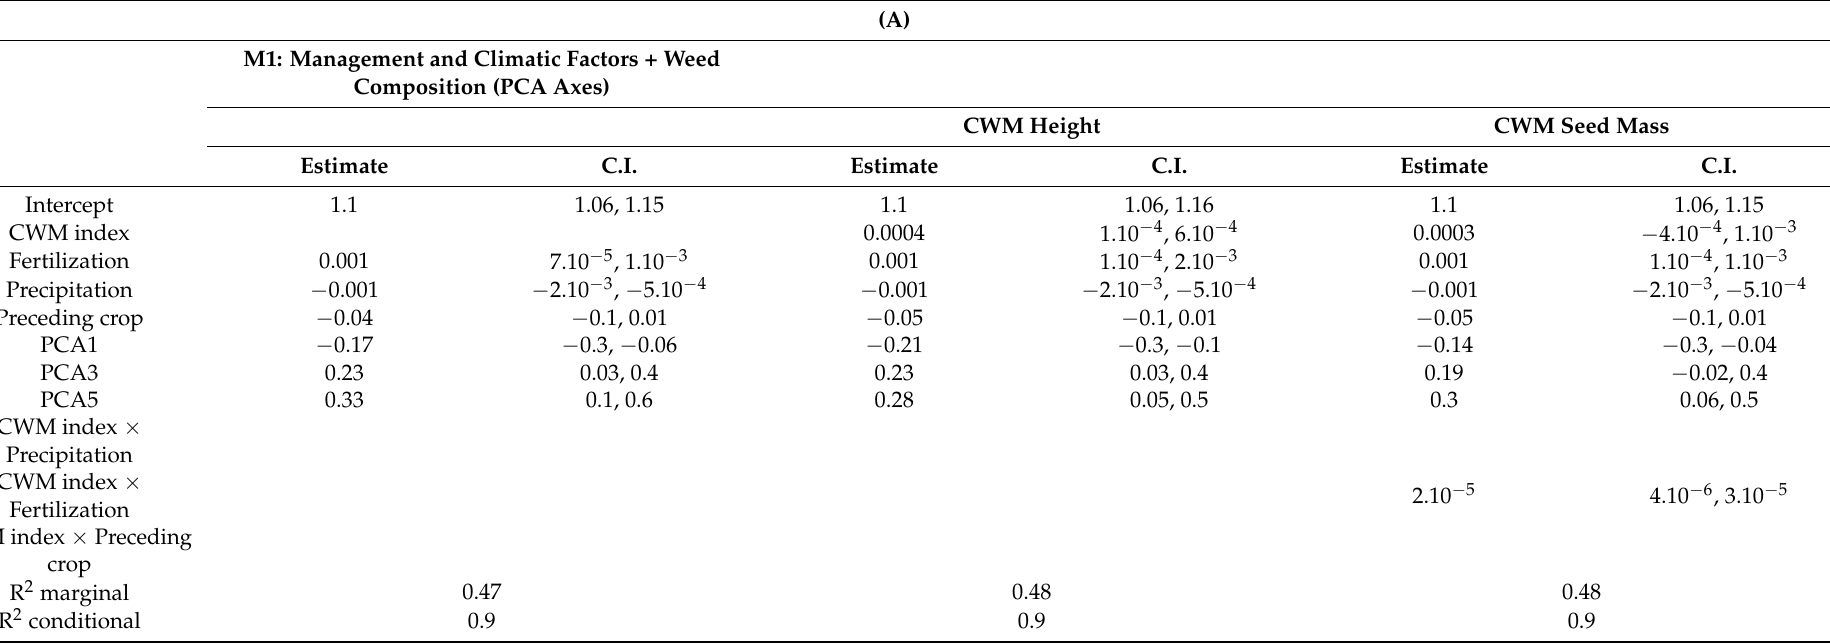
Table 3. (A) Estimates, confidence intervals (C.I.) and R 2 marginal and conditional values of the M1 model (management and climatic variables along with PCA axes), and of each of the models in which the inclusion of a community weighted means (CWM) index improved the M1 parsimony for explaining protein concentration in wheat grains. The reference category for preceding crop was sunflower and cereal crops. (B) Estimates, confidence intervals (C.I.) and R 2 marginal and conditional values of models for which the inclusion of FDis functional dispersion index (FDis) improved the parsimony of M1 in explaining protein concentration in wheat grain. The reference category for preceding crop was sunflower and cereal